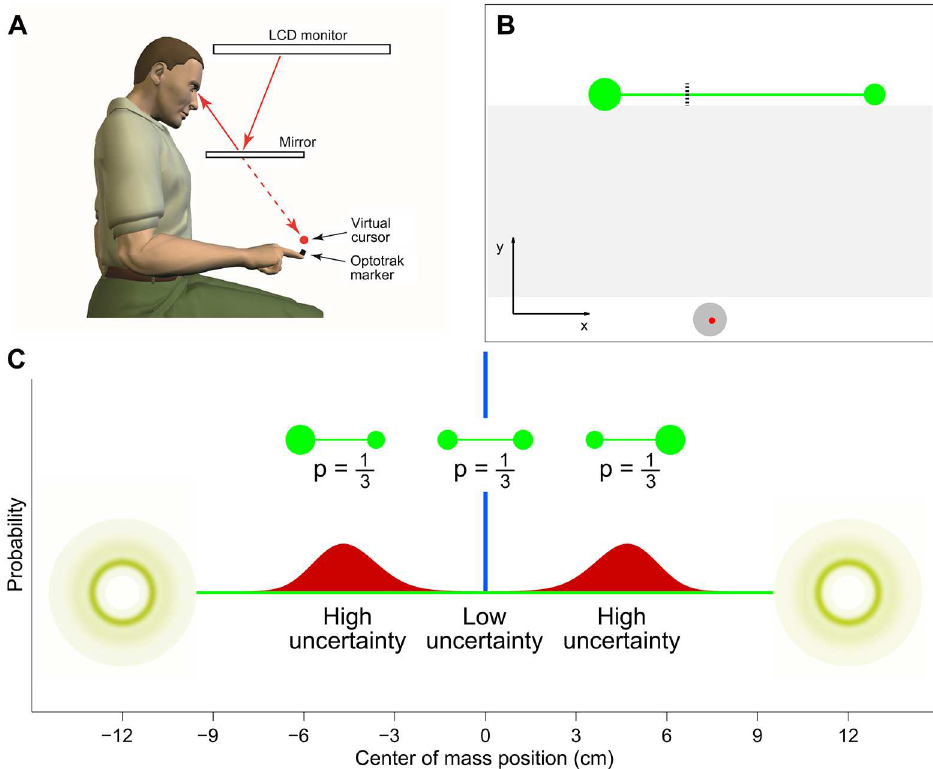
Fig 1. Experimental setup. A: Subjects wore an Optotrak marker on the tip of their right index finger. The visual scene from a CRT monitor, including a virtual cursor that tracked the finger position, was projected into the plane of the hand via a mirror. B: The screen showeda home positionat the bottom (grey circle), the cursor (red circle), here at the start of a trial, and the object at top (green dumbbell).The task consisted of locatingthe center of mass of the object, here indicatedby the dashed line. Visualfeedbackof the cursor was removedin the regionbetweenthe home position and the target line (here shadedfor visualizationpurposes). C: The two disks were separated by 24 cm and, dependingon the disks size ratio, the target (center of mass) was either exactly halfwaybetween the two disks ( p = 1/3; low uncertainty; blue distribution)or to the right ( p = 1/3) or left ( p = 1/3) of the midpoint (high uncertainty; red distributions), leadingto a trimodal distribution of center of